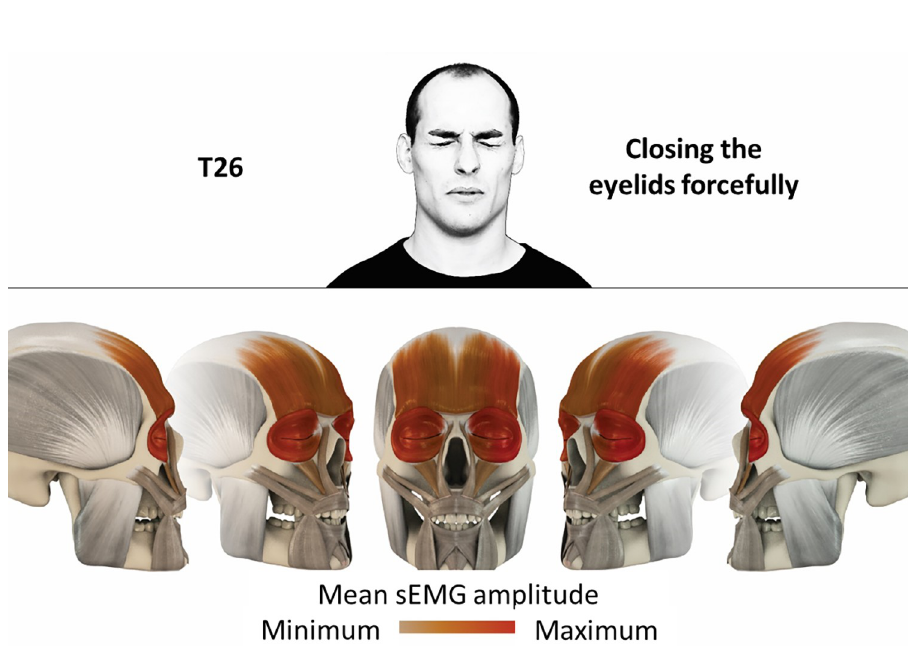
Fig 27. Color-coded facial muscle activation pattern of task T26. Closing eyelids forcefully. Animation by Jonas Laustro¨er.